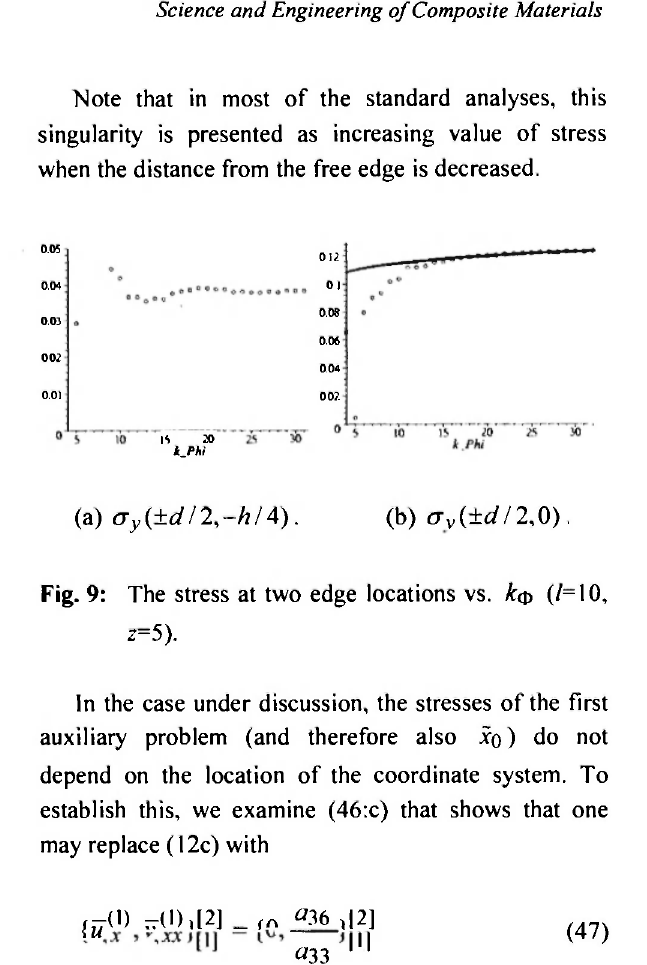
Fig. 8: The stress components due to P x tip load (/= 10, z=5).